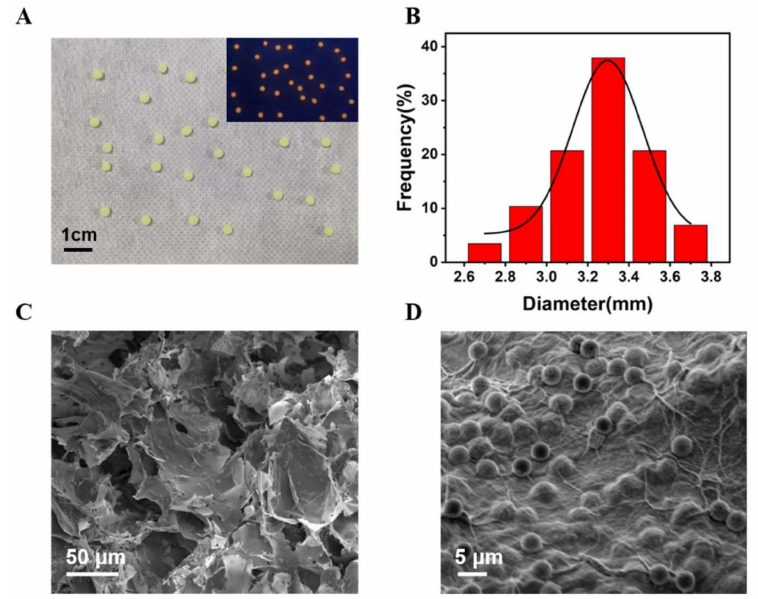
Figure 5. Characterization of Alg@MFM@QDs-LOx MSs. ( A ) Photograph of the microspheres under natural illumination. Inset: Photograph under a UV lamp. ( B ) The size distribution. ( C ) SEM image. ( D ) SEM image of MFMs attached to the Alg@MFM@QDs-LOx MSs.